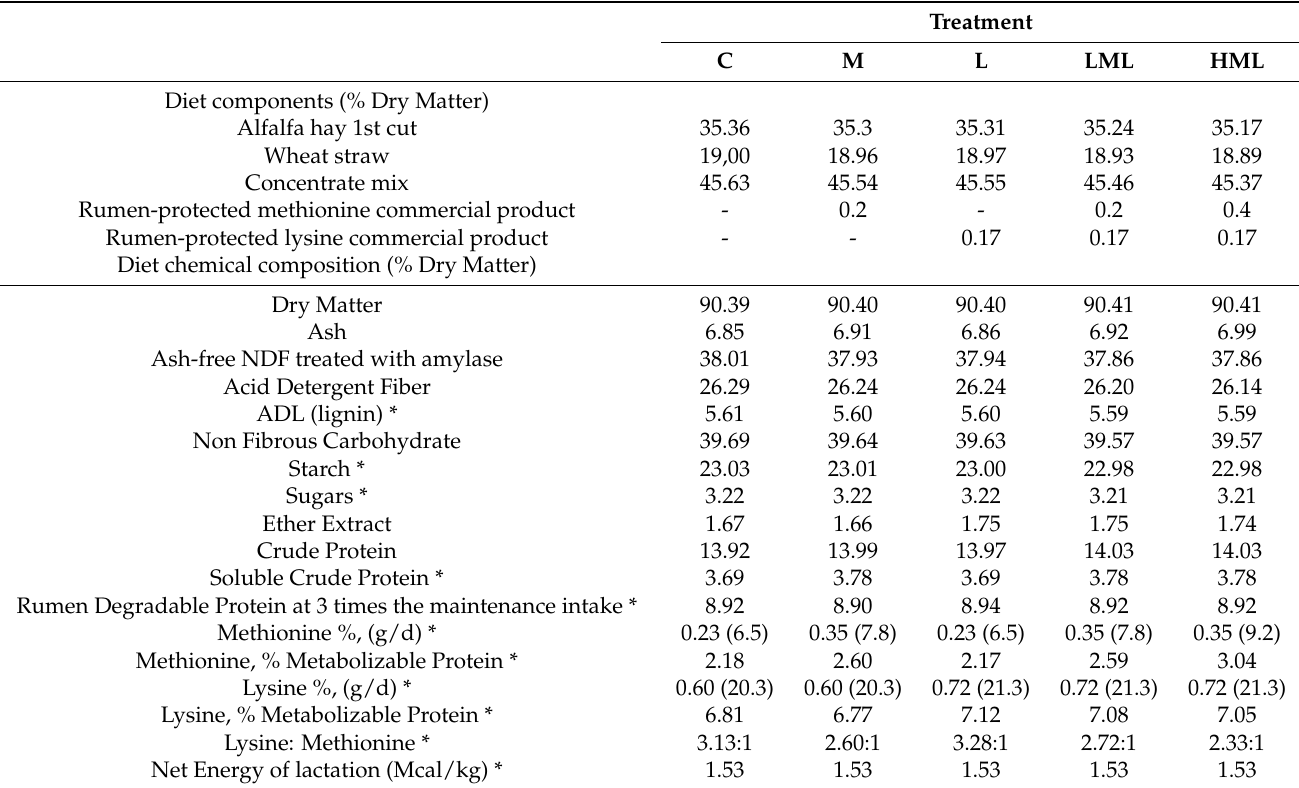
Table 1. Ration components (% of dry matter; DM) and chemical composition (% of DM) of the feeds administered to the groups (C, M, L, LML, and HML) of ewes involved in the